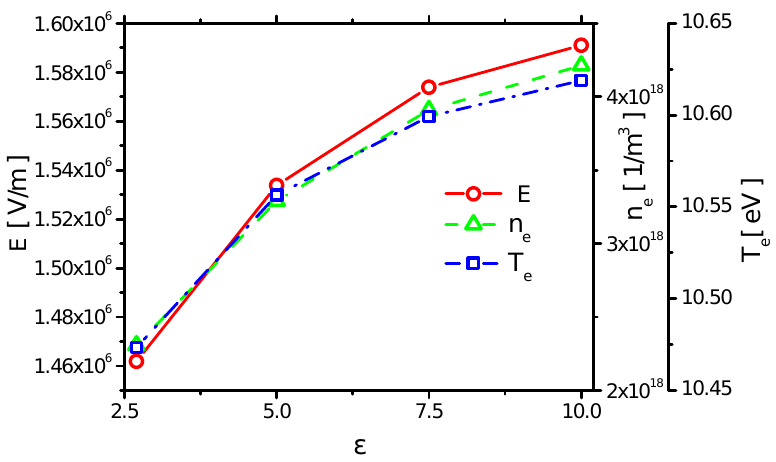
(cid:12) (cid:12) (cid:42) (cid:12) (cid:12) E (cid:12) (cid:12) , electron density n e , and